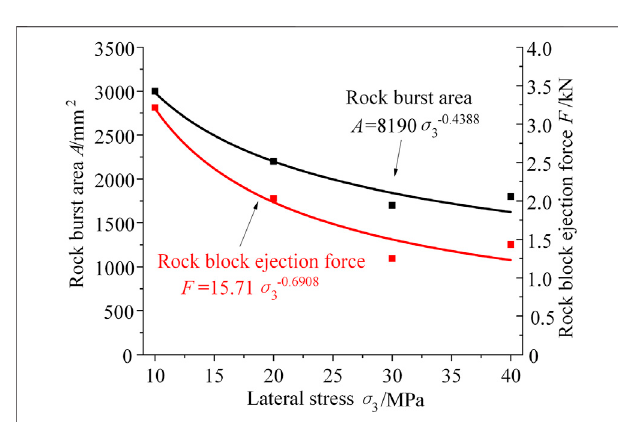
FIGURE 10 | Relationship among the rock burst area, rock block ejection force, and unloading velocity.